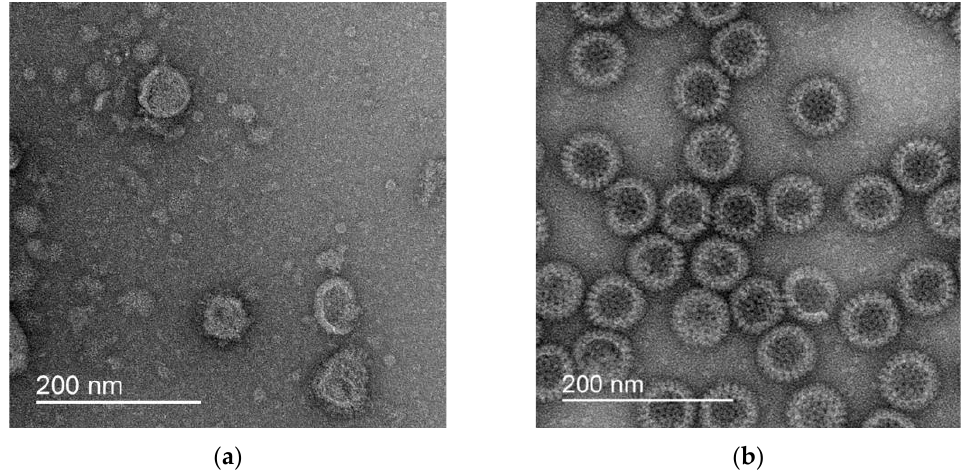
Figure 1. Photomicrographs of VLPs mimicking SARS-CoV-2 ( a ) and rotavirus A ( b ).